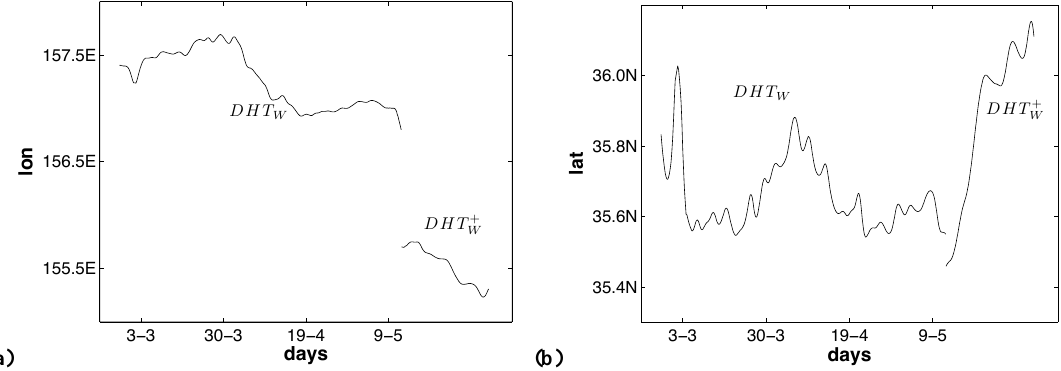
Fig. 3. Path of limit coordinates for DHT W and DHT +